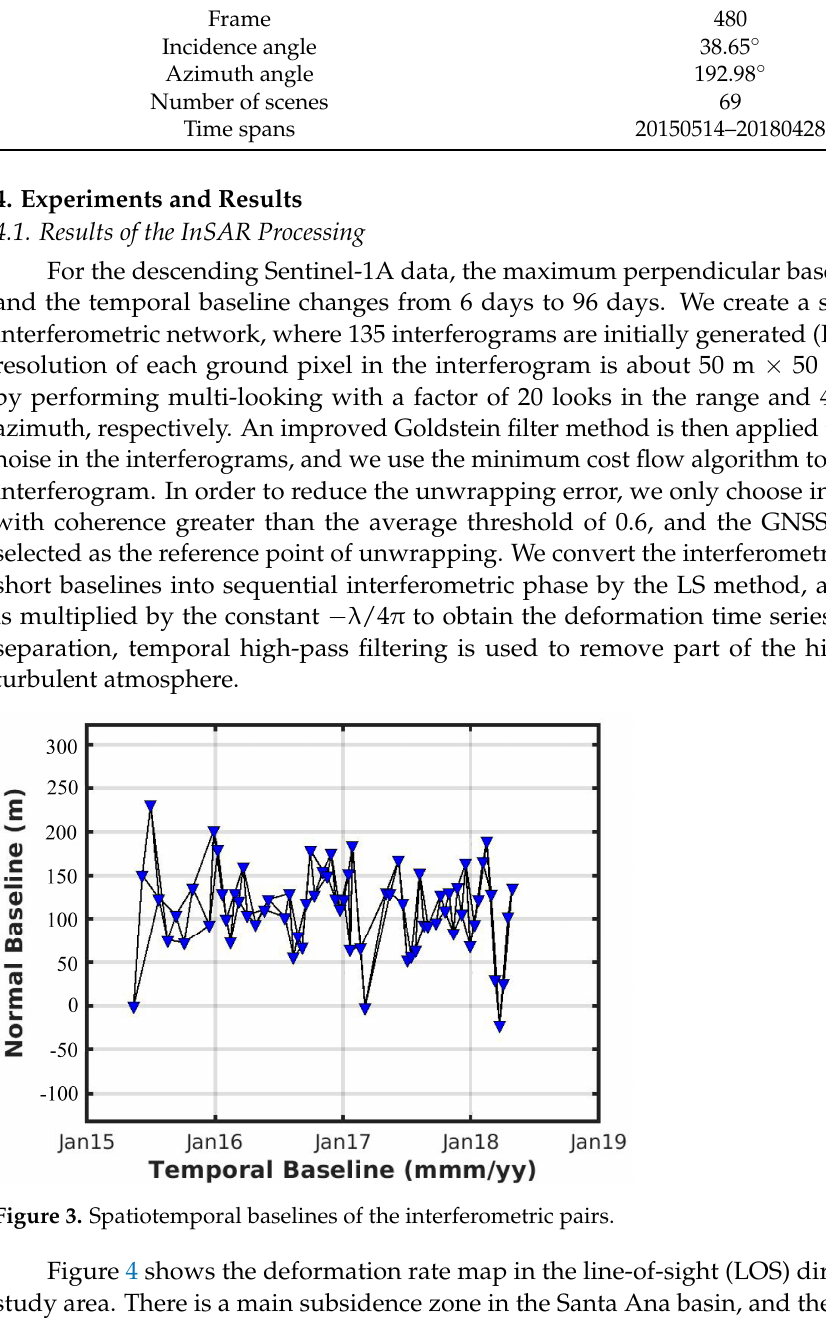
Table 1. Parameters of the SAR datasets used in the study.